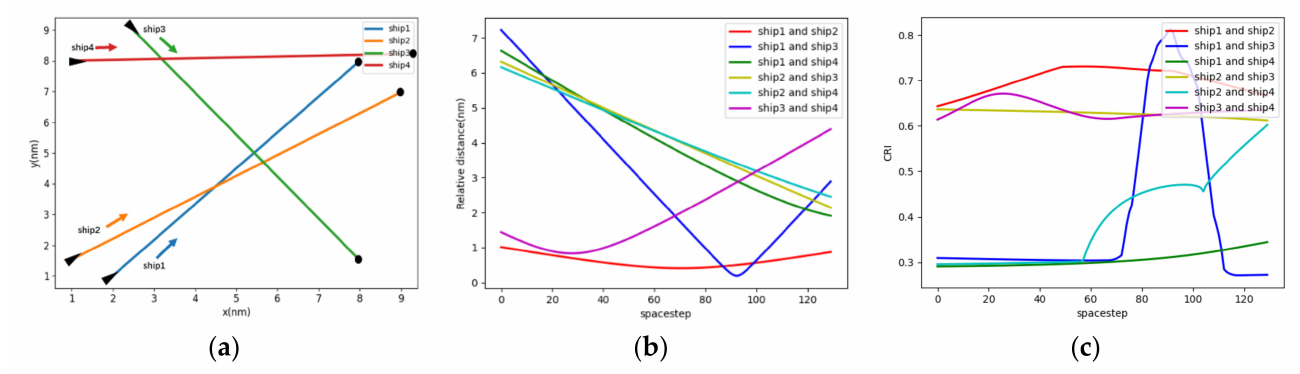
Figure 14. The CA result of three-ship encounter based on CS-STHA. ( a ) trajectories; ( b ) relative distance; ( c ) CRI.